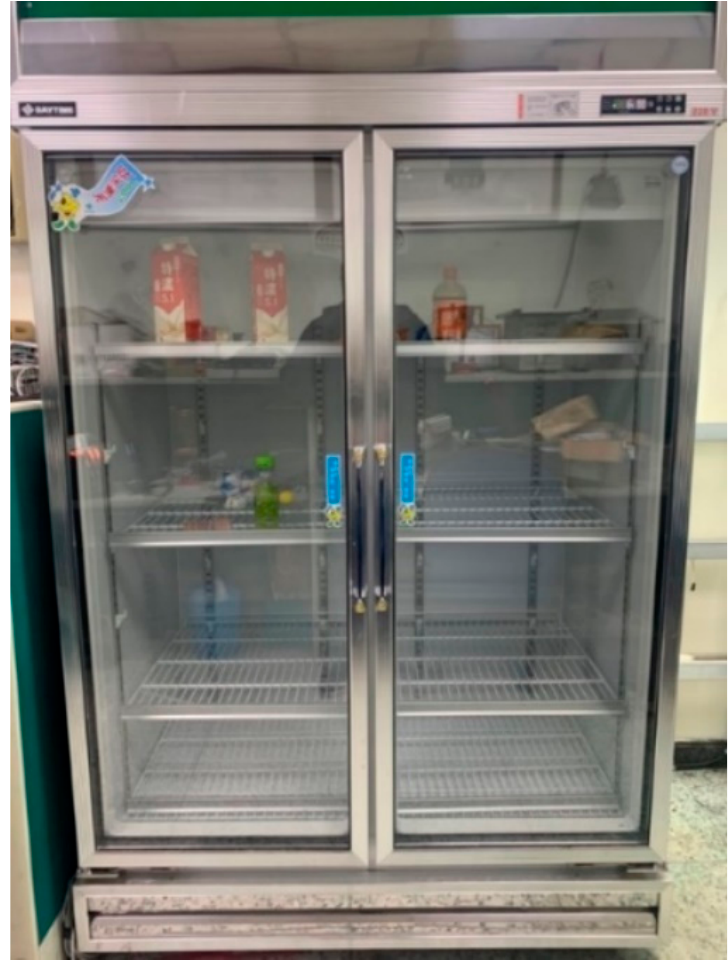
Figure 11. Refrigerated cabinet to be tested. Table 3. Specifications of compressor of refrigerated cabinets.